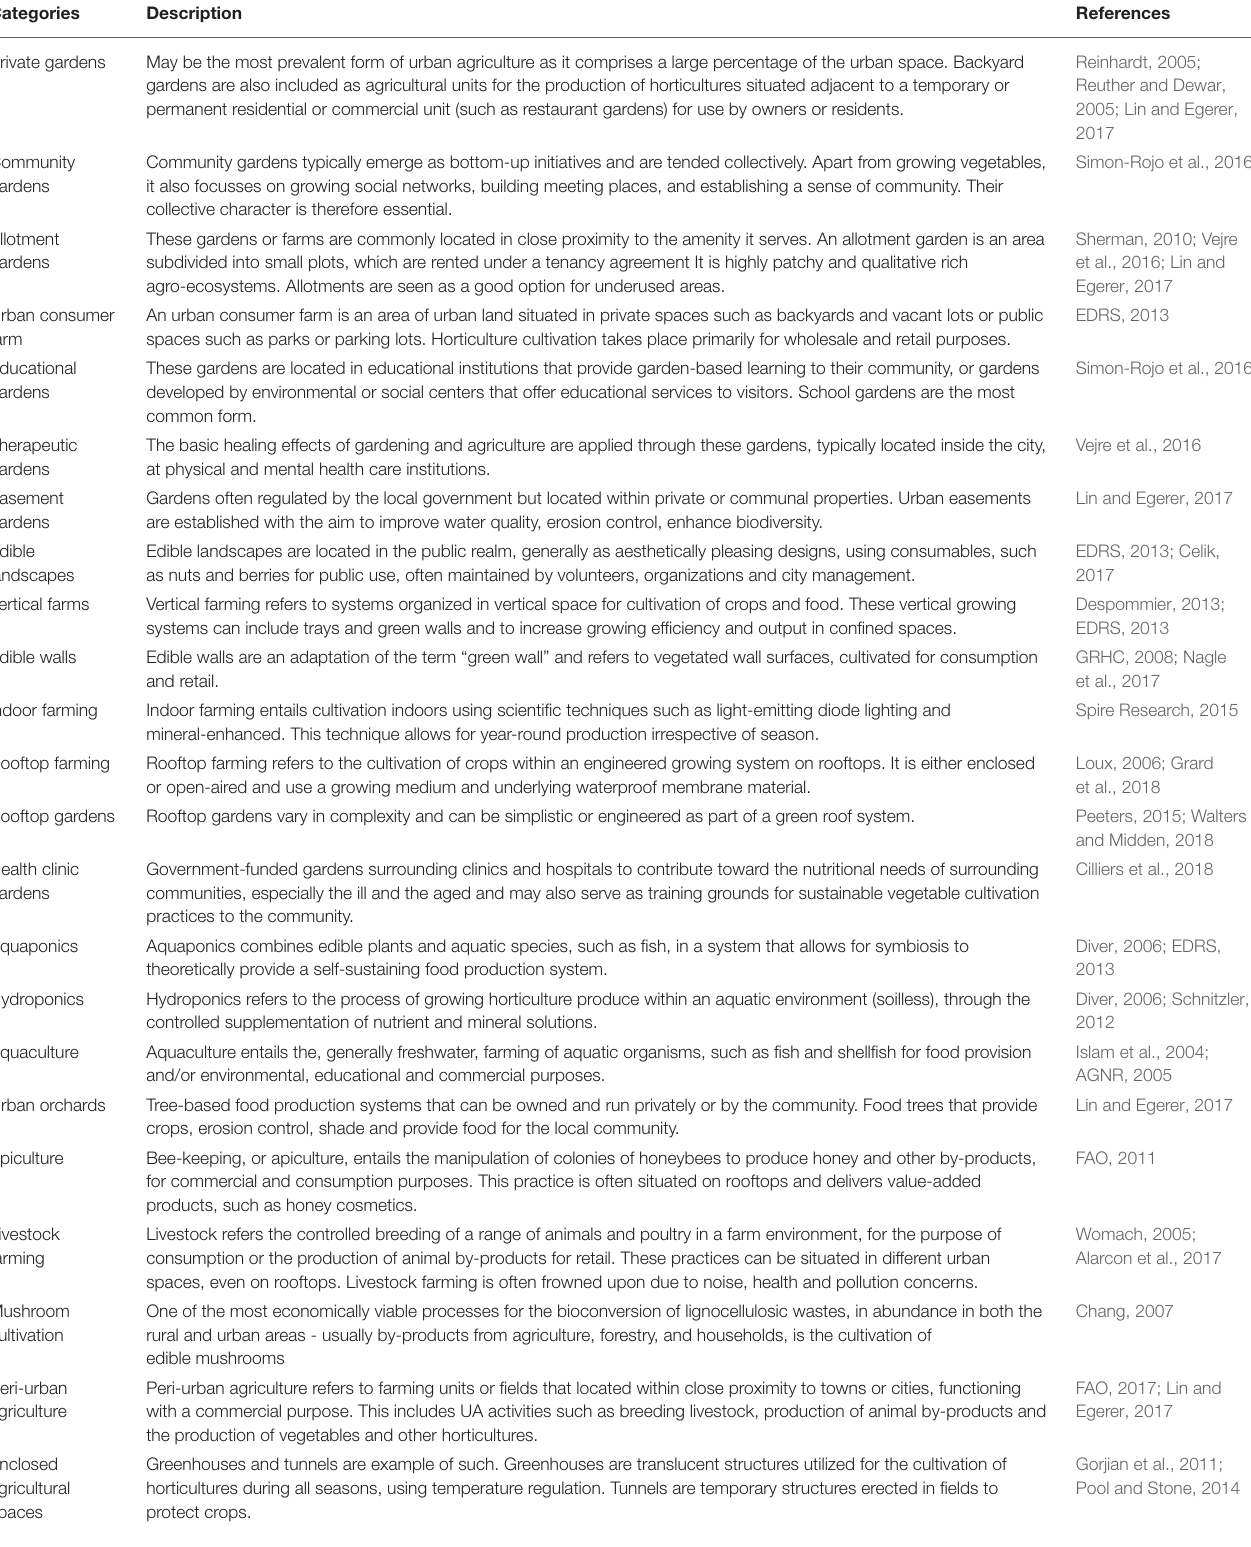
TABLE 1 | Different descriptions of UA systems and practices indicating the diversity of